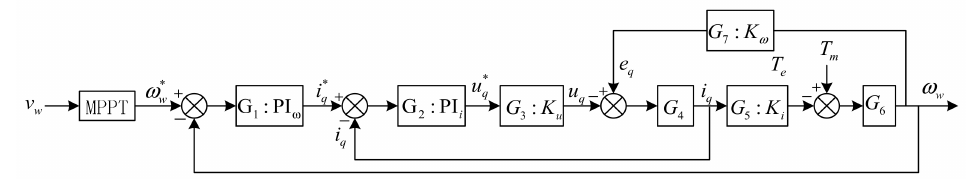
Figure 3. Diagram of generator-side in